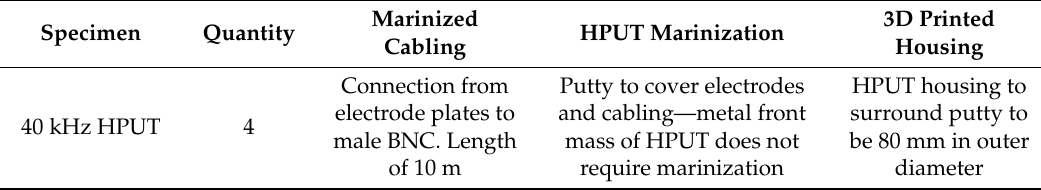
Table 3. HPUT marinization requirements.